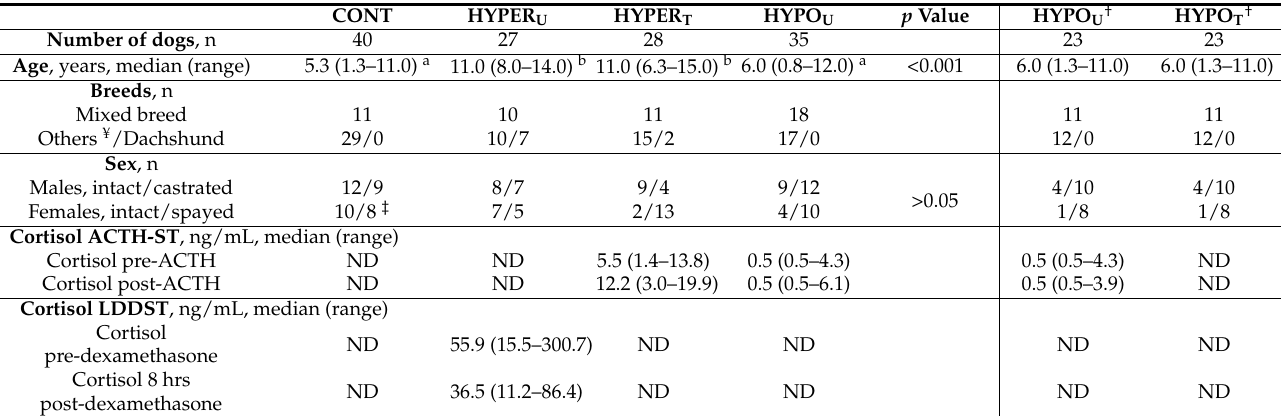
Table 1. Demographic data of 153 serum samples from dogs in the groups of CONT ( n = 40), HYPER U ( n = 27), HYPER T ( n = 28), HYPO U ( n = 35), and HYPO T ( n =